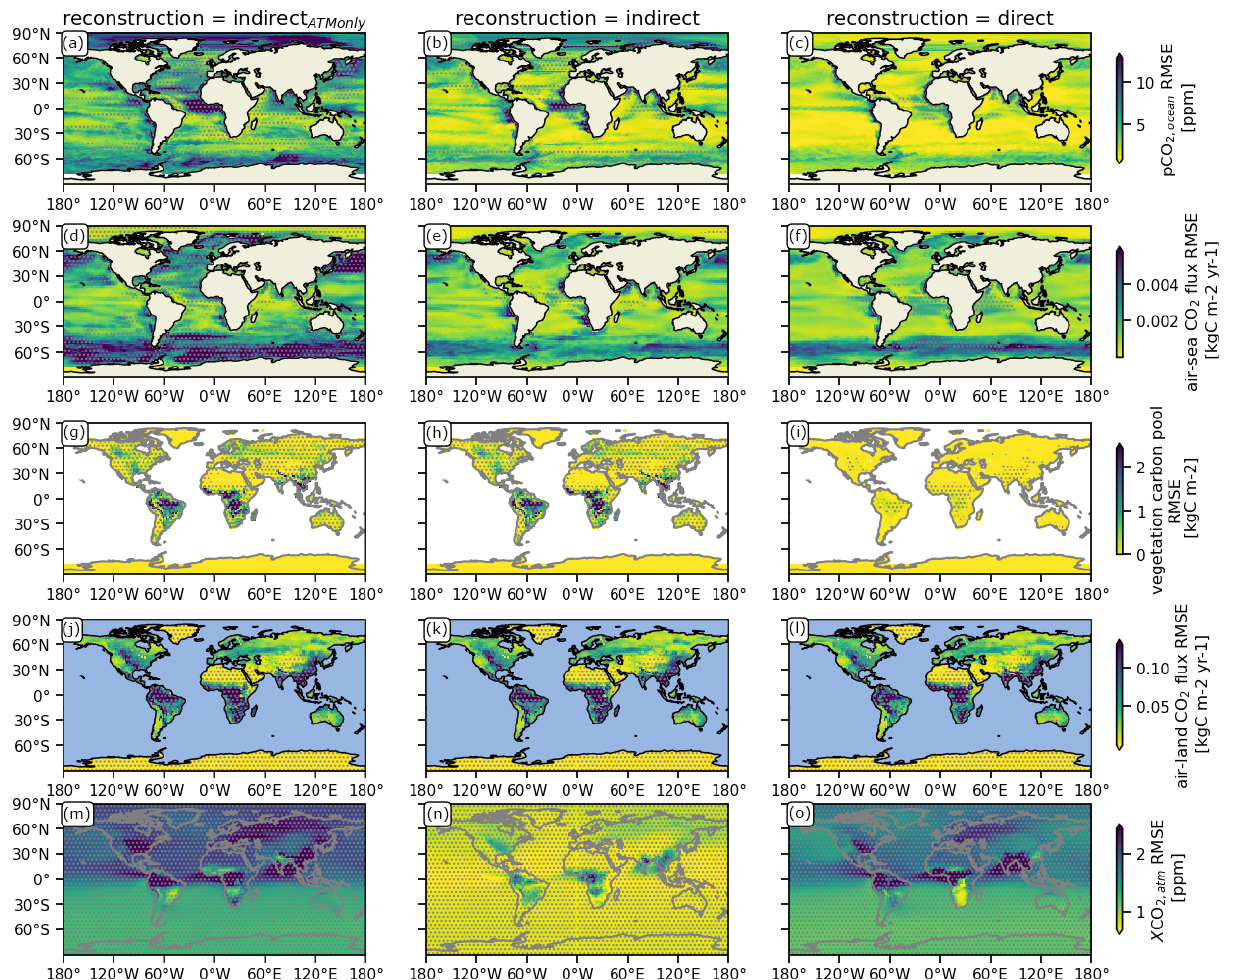
Figure B2. The same as Fig. 2 but for the RMSE. Gray stippling shows where the RMSE is worse than the 5th-percentile RMSE threshold from random target block resampling, i.e., the reconstruction is not significantly better than internal